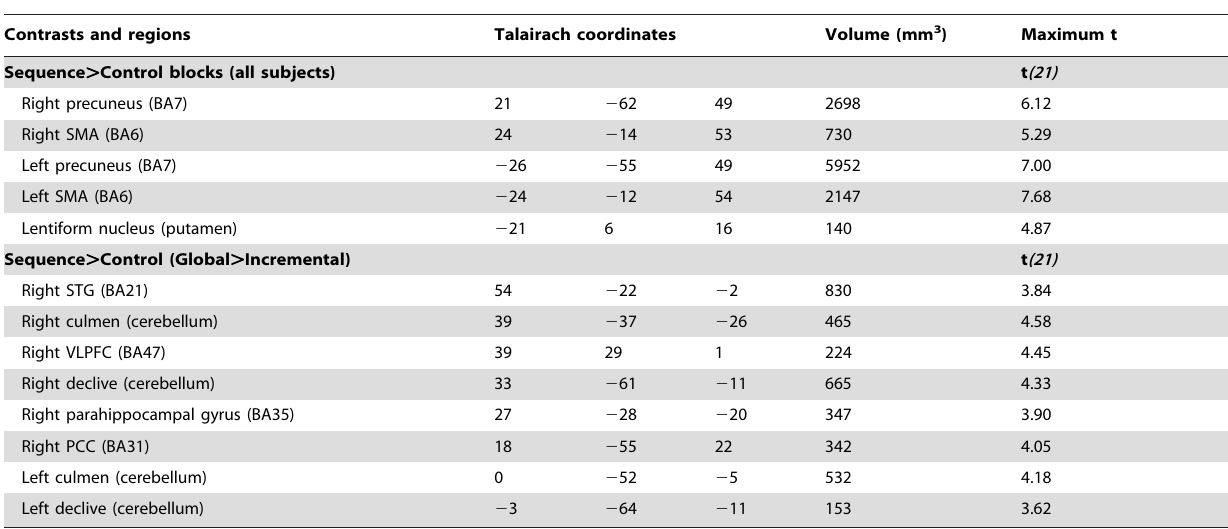
Table 2. Brain regions activated by contrast [ Sequence blocks . Control blocks